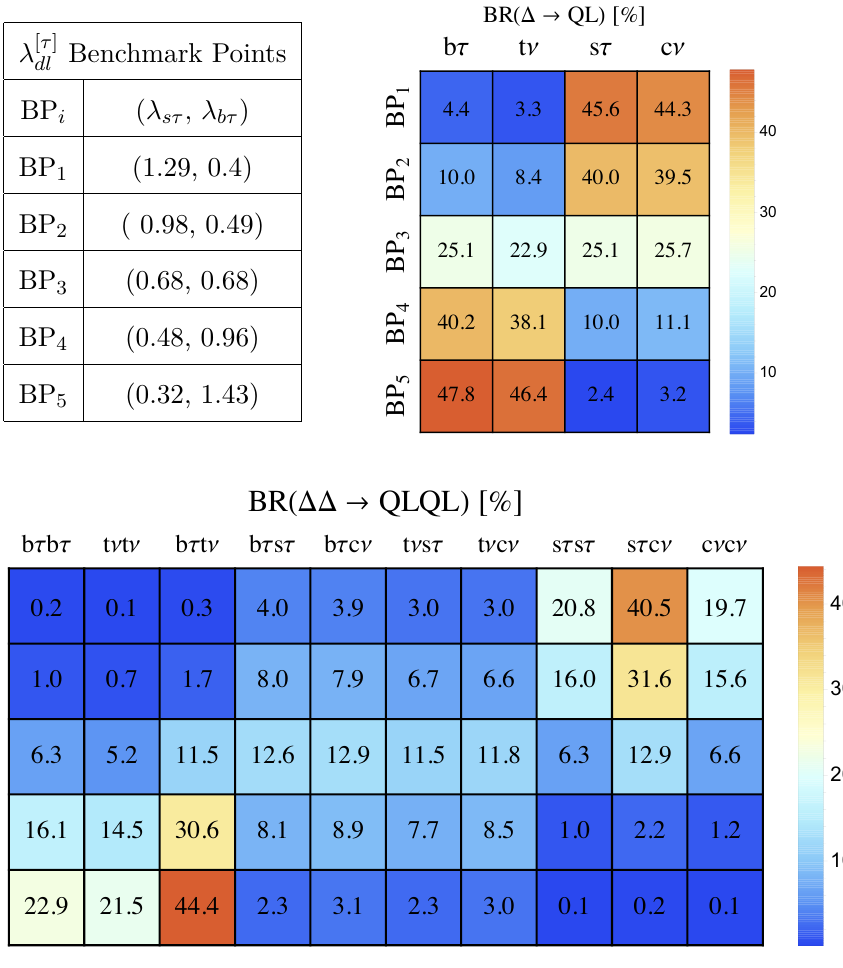
Table 2 . BR (∆(∆) → QL ( QL )) for 2 TeV LQ Benchmark Points from the λ [ τ ] All asymmetric decay BR have an additional × 2 factor because of